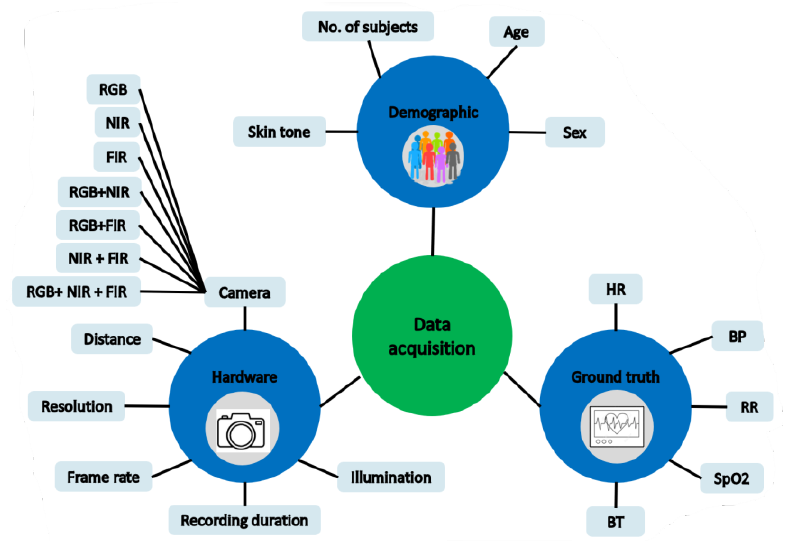
Figure 3. Data acquisition according to study design, hardware, and ground truth.